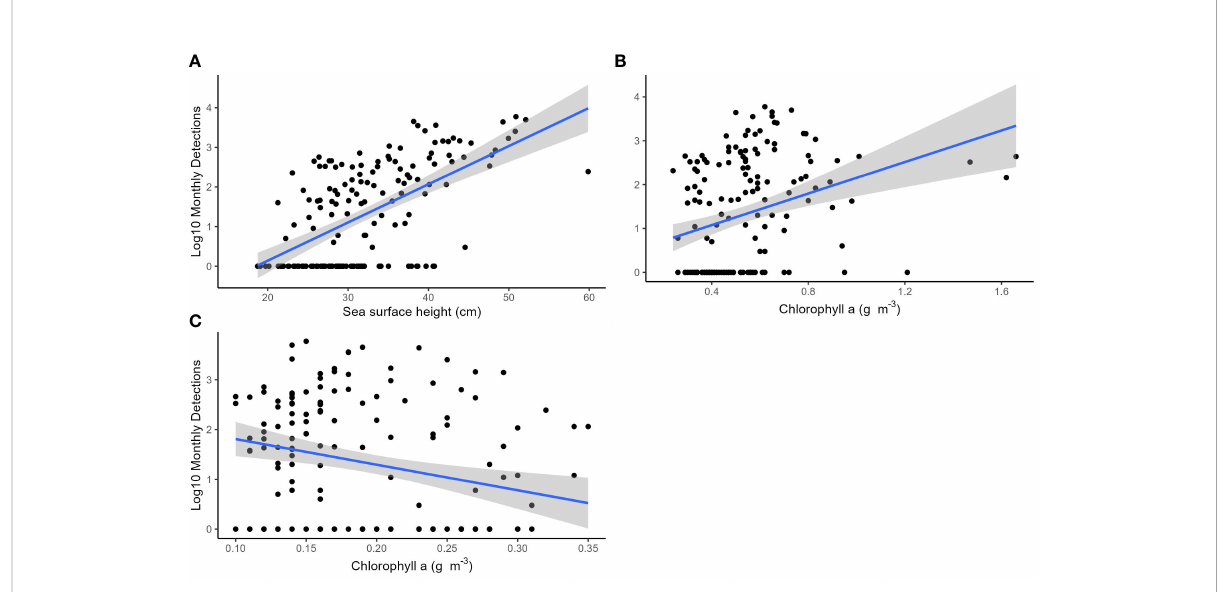
FIGURE 7 Scatterplots showing the correlation between the log 10 monthly EIO pygmy blue whale call detections and (A) monthly average sea surface height at the Cape Leeuwin, (B) chlorophyll a measured at the Bonney Upwelling and (C) chlorophyll a measured at the Cape Leeuwin hydrophone. All environmental variables were averaged across a 1° x 1° latitude and longitude grid. The blue lines represent the lines of best fi t and the grey shaded areas are estimated 95% con fi dence